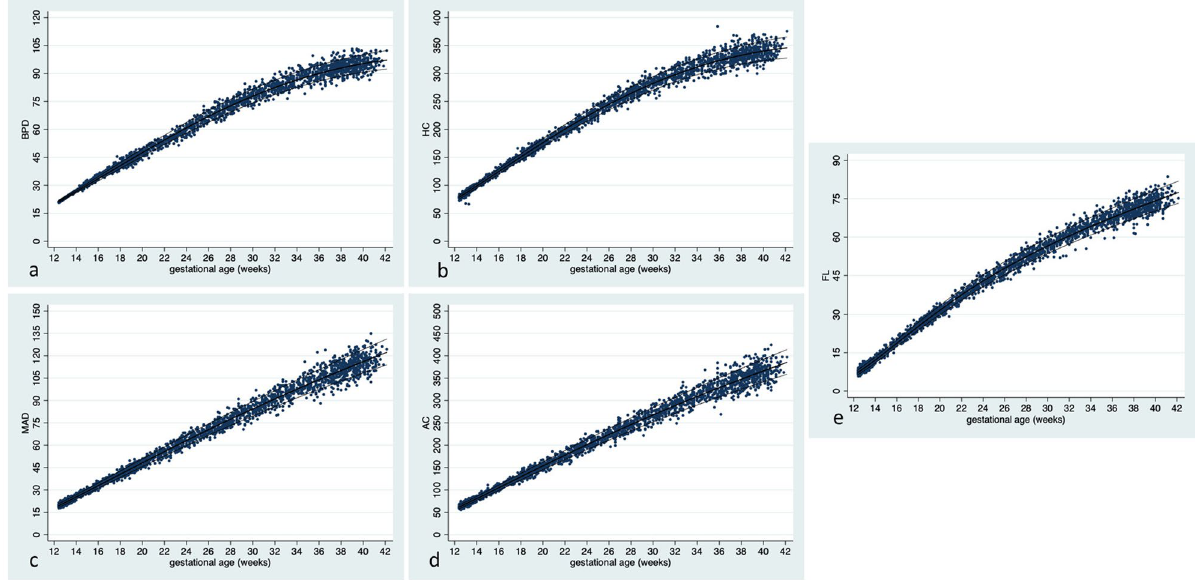
Figure 2. Raw data with fitted percentiles (10, 50, 90) for each estimated biometrical measurement in mm by gestational age (GA). ( a ) Shows biparietal diameter (BPD) by GA (n = 2586), ( b ) shows head circumference (HC) by GA (n = 2571), ( c ) shows mean abdominal diameter (MAD) by GA (n = 2585), ( d ) shows abdominal circumference (AC) by GA (n = 2561) and ( e ) shows femur length (FL) by GA (n =